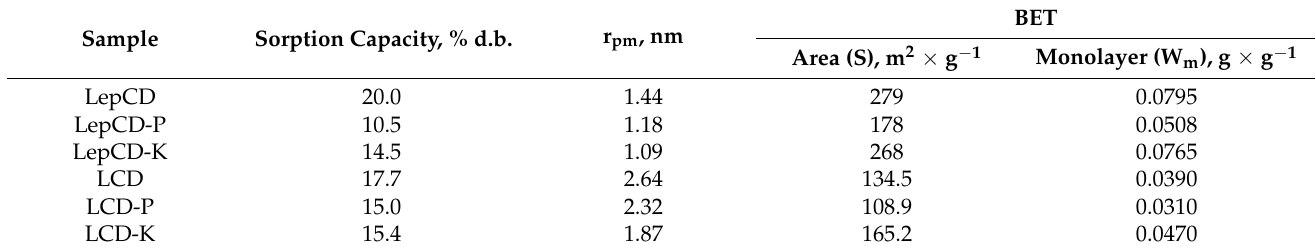
Table 2. Relevant BET data related to the studied materials.